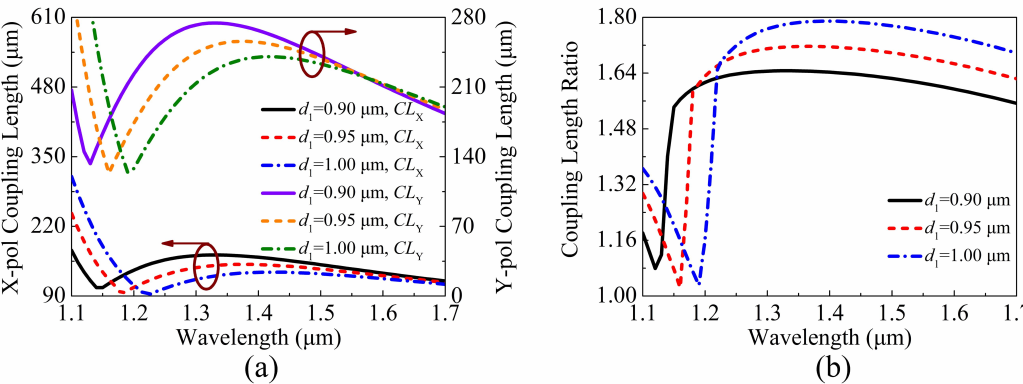
Figure 5. The variations of the ( a ) CL X , CL Y , and ( b ) CLR of the proposed V-DC-PCF PBS for different d 1 .